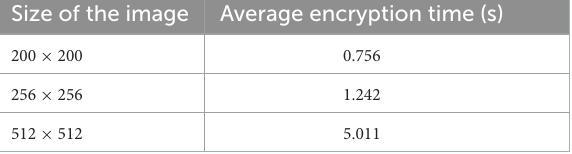
TABLE 16 Encryption time. Size of the image Average encryption time (s) 200 ×